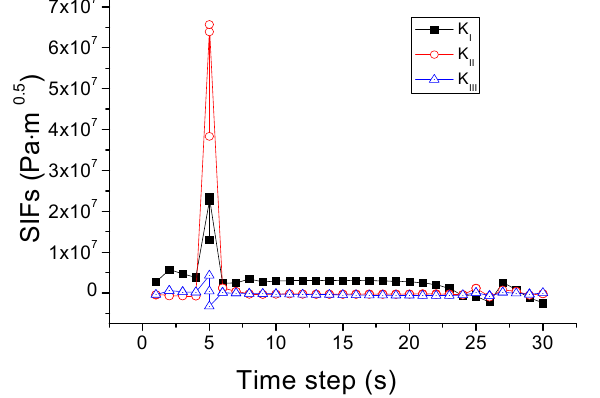
Figure 14. Variation of SIFs associated with the mixed-mode criterion based on energy release rates.